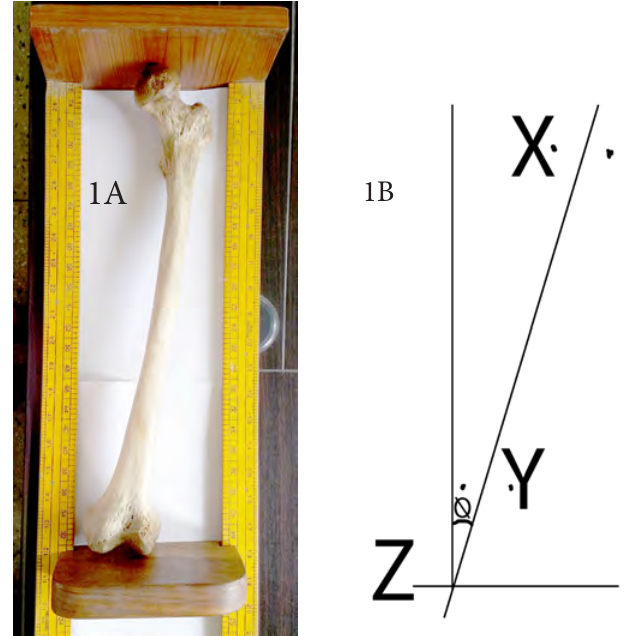
Fig 1A, 1B : Measurement of femoral bicondylar angle with osteometric board